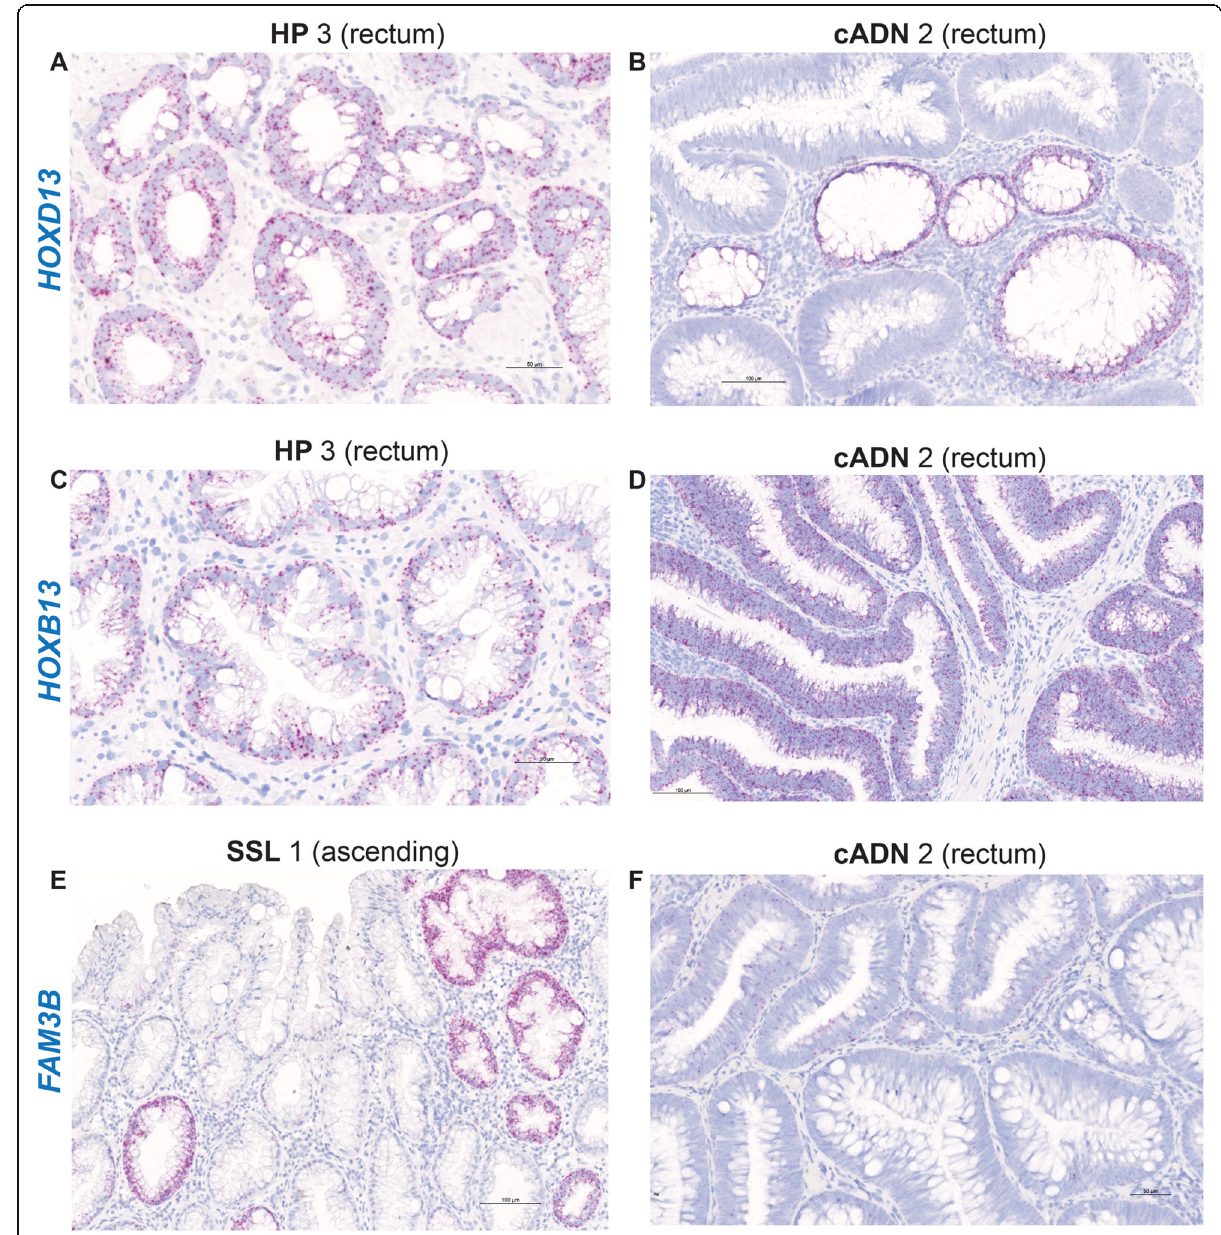
Fig. 6 In situ hybridization analysis of HOXD13 , HOXB13 , and FAM3A mRNAs in serrated lesions and cADNs. These three mRNAs are not specifically expressed in serrated lesions versus cADNs or vice versa. While HOXD13 and HOXB13 are expressed prevalently in lesions of the distal colon and rectum, FAM3A is prevalently found in proximal colon lesions: these patterns reflect the expression specificity in the normal mucosa in the distal and proximal segments of the large intestine. Details on the expression patterns of these three mRNAs in normal mucosa and in the investigated lesions are shown in Supplementary Figs. 15, 16, and 17, and summarized in Table